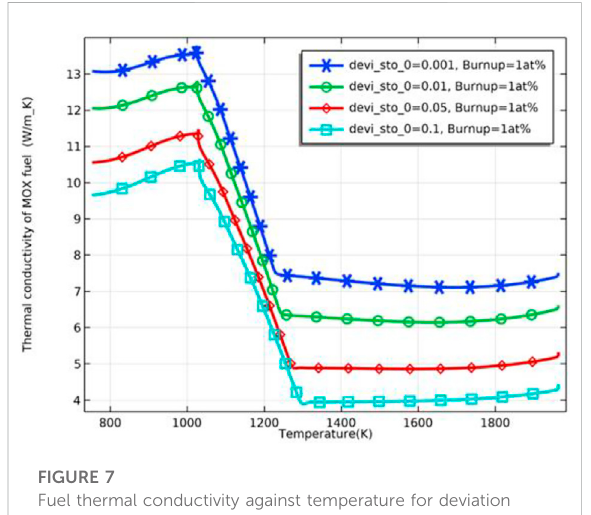
FIGURE 9 Pellet inner/outer surface temperature variation against